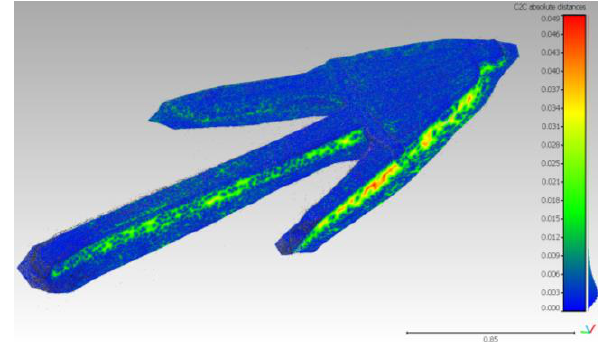
Figure 8. Cloud-to-cloud distance after filtering.